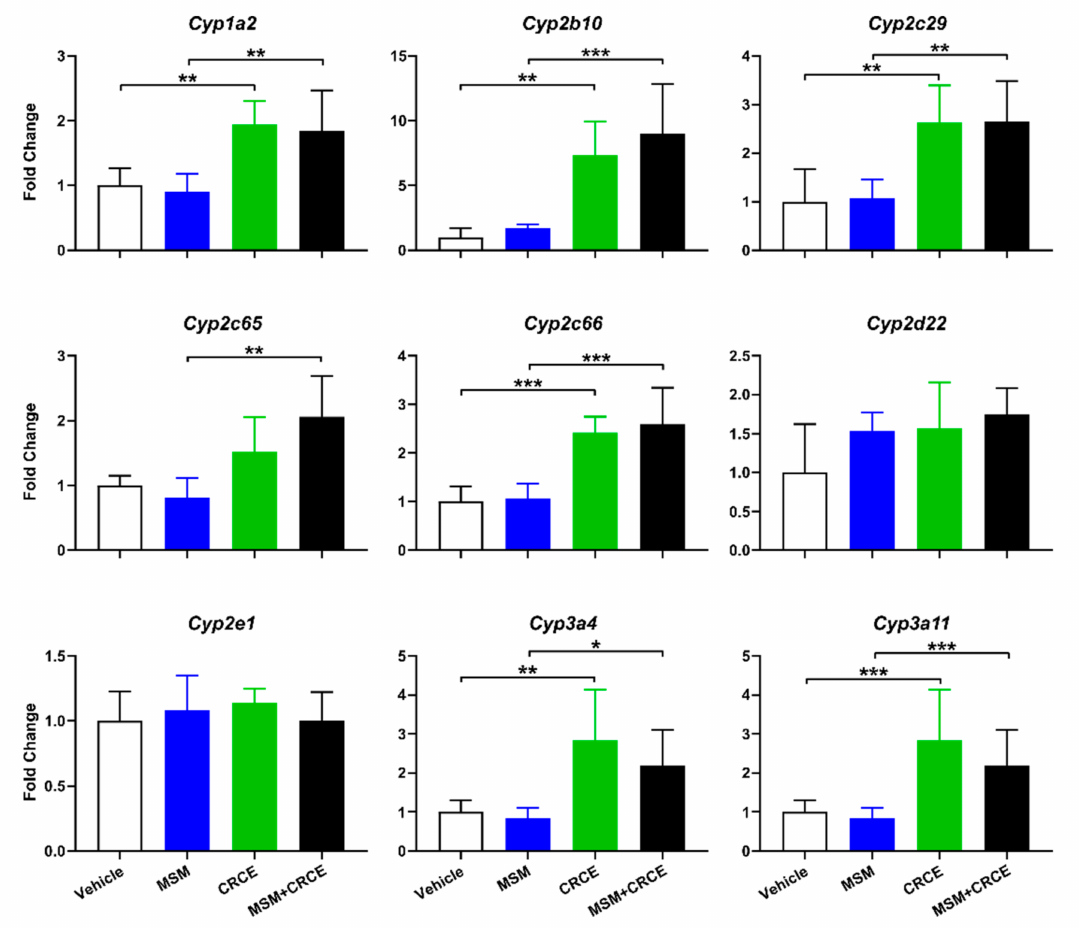
Figure 4. E ff ects of administration of MSM, CRCE, or MSM / CRCE on intrahepatic expression of cytochrome P450s. Livers were collected 24 h after the last gavage and gene expression was measured using the quantitative real-time (qRT) PCR. Data was analyzed by two-way ANOVA with Bonferroni post-test and presented as mean ± SD fold change from vehicle ( n = 6–8), with * as p < 0.05; ** as p < 0.01, and *** as p < 0.001. MSM—methylsulfonylmethane, CRCE—cannabidiol-rich cannabis